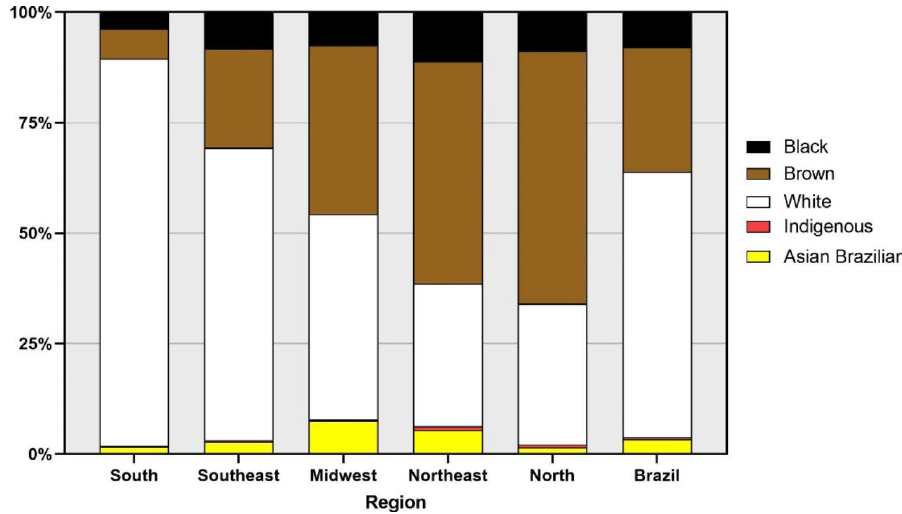
Fig. 2 The racial composition of the population samples of each region and of the total, by self-reported skin color, according to the REDOME